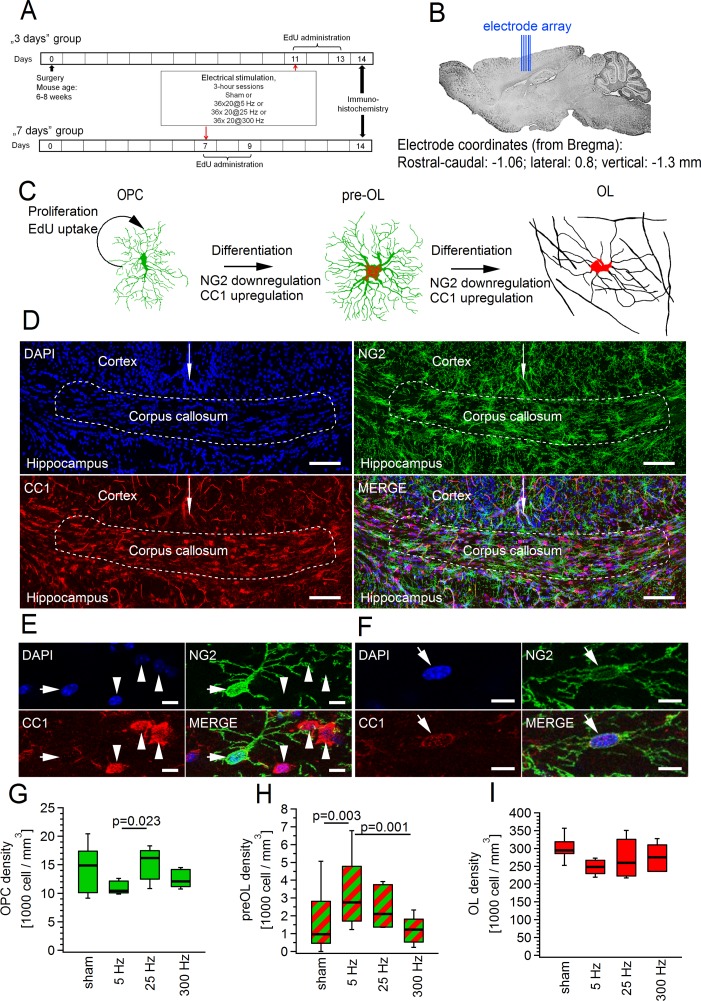
Transient stimulation of callosal axons in vivo at 5 Hz but not at 25 Hz or 300 Hz promotes differentiation of oligodendrocyte precursor cells (OPCs) into oligodendrocytes (OLs).(A) Scheme describing experimental design for studying effects of callosal stimulation in vivo on proliferation and differentiation of OPCs. (B) Scheme showing sagittal section of mouse brain and the position of an electrode array used for electrical stimulation of the corpus callosum. (C) Schematic drawings of the investigated cell types. For cell counting, OPCs were identified as NG2+CC1- cells, premyelinating OLs (pre-OLs) as NG2+CC1+ cells, and myelinating OLs as NG2- cells expressing CC1 in their soma. Within the OL lineage, 5-ethynyl-2´-deoxyuridine (EdU) only labels proliferating OPCs. However, the progeny of an EdU+ OPC will be EdU+. (D) Coronal sections of the corpus callosum. Maximum intensity projection (from 14 successive confocal planes) showing triple channel immunofluorescent labelling with DAPI (top left, blue), NG2 (top right, green), CC1 (bottom left, red), and the overlay of 3 channels (bottom right). White dashed line denotes the middle region of the corpus callosum used for cell counting. White arrow indicates midline of the brain. Scale bars: 100 μm. (E) As in (D), but higher magnification example of one NG2+CC1- OPC (arrow) and three NG2-CC1+ OLs (arrowheads). Maximum intensity projection was generated from a z-stack of 3 successive confocal planes. Note that some processes of an NG2+ OPC are clearly visible. Scale bars: 10 μm. (F) As in (E), but an example of one NG2+CC1+ pre-OL (arrow). Note that the expression level of NG2 is weaker than in OPCs, and the expression level of CC1 is weaker than in OLs (Fig 7E). Scale bars: 10 μm. (G–I) Average density of (G) OPCs, (H) pre-OLs, and (I) OLs in corpus callosum upon electrical stimulation of callosal axons at 5 Hz (n = 5 mice, total 13 slices), 25 Hz (n = 5 mice, total 16 slices), or 300 Hz (n = 5 mice, total 17 slices) versus sham-stimulated controls (n = 7 mice, total 25 slices). Note that differentiation rate was significantly increased by 5 Hz but not by 25 Hz or 300 Hz stimulation (H). Nested ANOVA and post hoc Tukey were used for statistical analysis (S13 Data). Box and whisker plots: the bottom and top of each box represent 25th and 75th percentiles of the data, respectively, while whiskers represent 10th and 90th percentiles. The midline represents the median. The numerical data used in G–I are included in S14 Data.